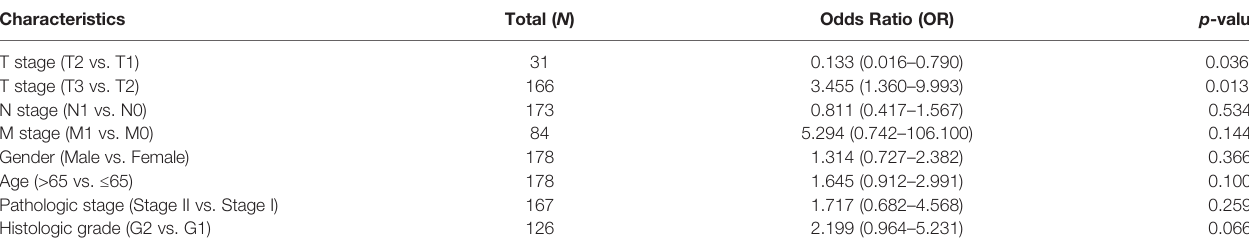
TABLE 1 | The logistic analysis of correlation between AQP5 and clinical characteristics in patients with PAAD.